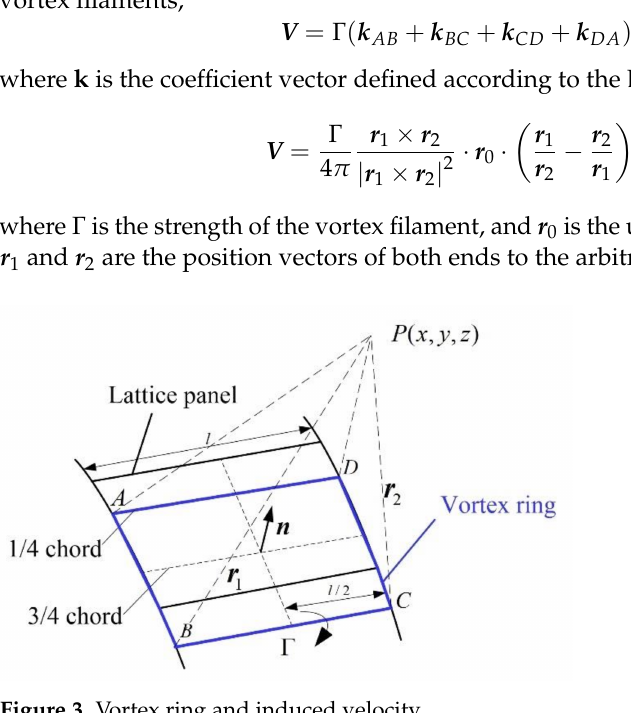
Figure 3. Vortex ring and induced velocity.